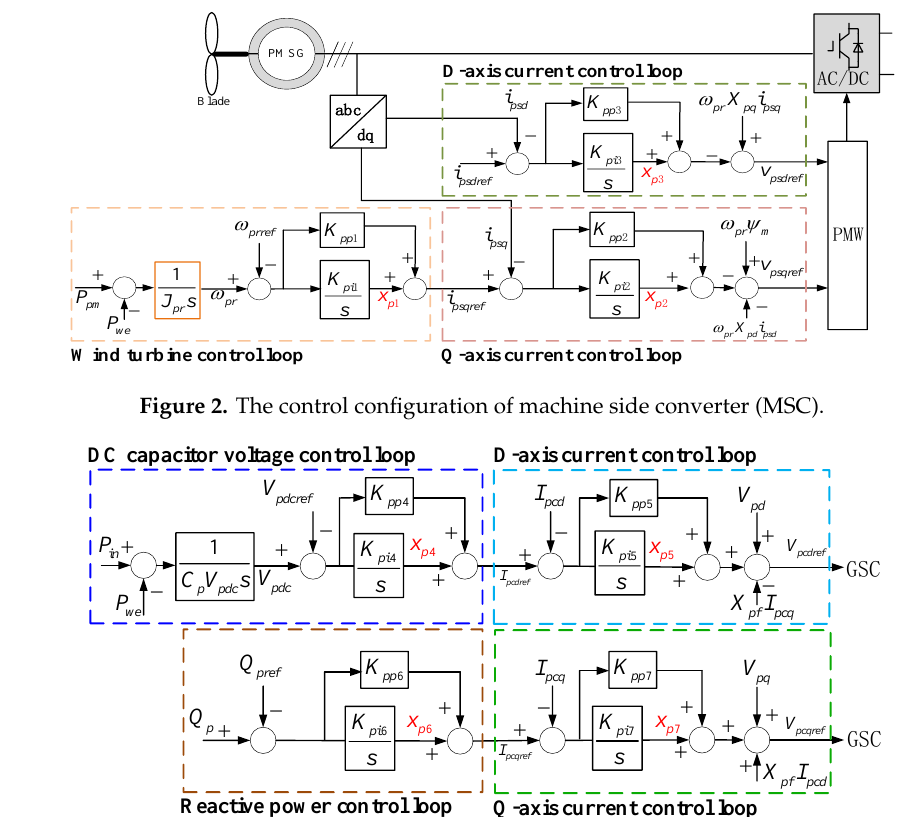
Figure 3. The control configuration of grid side converter (GSC).